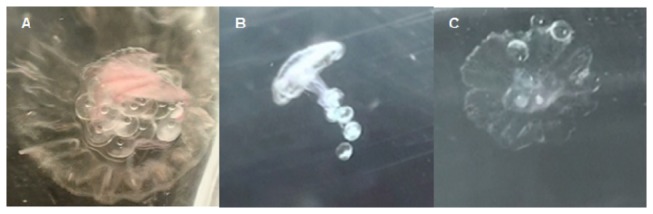
Ephyrae with eggs in different situations: A) ephyra on a Petri disc after feeding, B) ephyra capturing eggs during feeding incubation under stirred conditions, C) ephyra capturing eggs during feeding incubation under unstirred conditions.